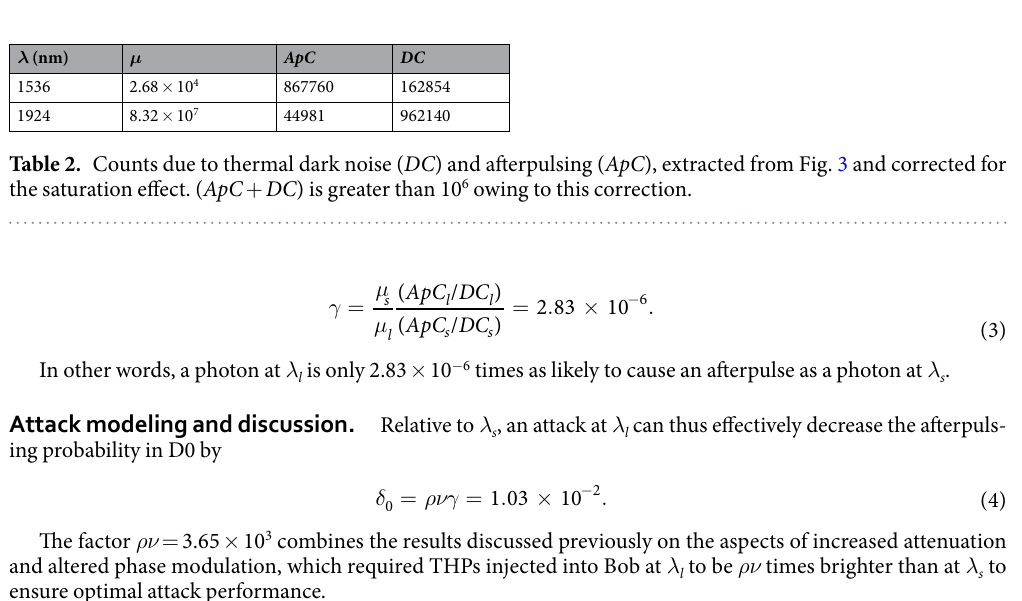
λ λ λ − − δ δ = × = . × . With afterpulsing amplitudes reduced by δ 0 and δ 1 , we have repeated the simulation of the attack strategy pro- posed in ref. 11 . Let us first recap this strategy, in which Eve manipulates packets or ‘frames’ 13 of quantum signals traveling from Alice to Bob in the quantum channel. For instance, she may simply block the quantum signals for several contiguous time slots in a frame, thereby preventing any detection clicks (except those arising from